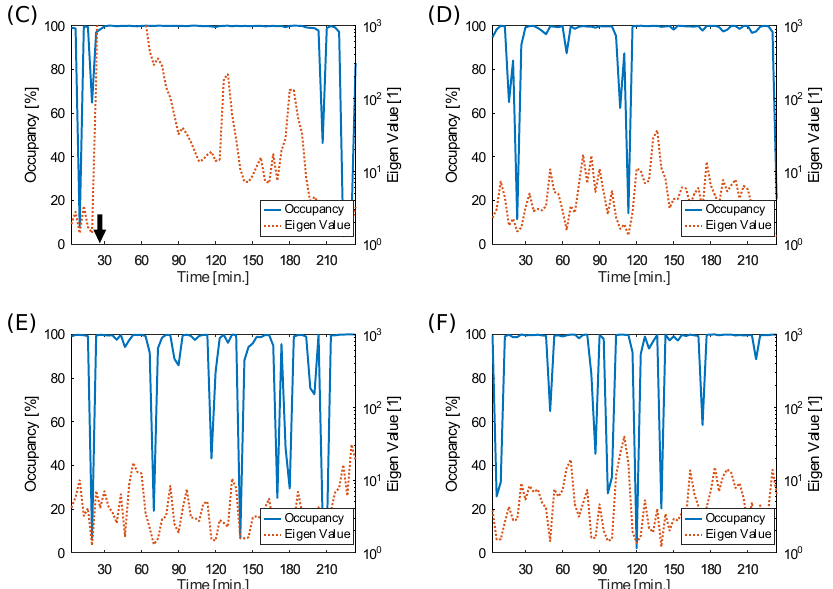
Figure 9. Occupancy rate and the first eigenvalue around the Kumamoto earthquake for ( A ) 2016/106/8-12, ( B ) 2016/106/12-16, ( C ) 2016/106/16-20, ( D ) 2016/106/20-24, ( E ) 2016/107/0-4, ( F ) 2016/107/4-8.